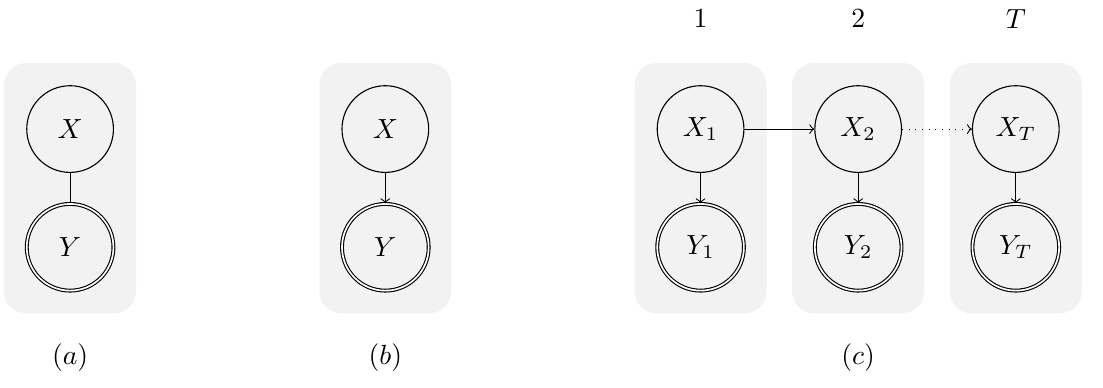
Figure 1. Graphical representation of three different types of classifier, where X represents a hidden state and Y an observation that is used to conclude information about X : ( a ) discriminative classifier; ( b ) generative classifier without temporal knowledge; and ( c ) generative classifier with temporal knowledge (figure adapted from